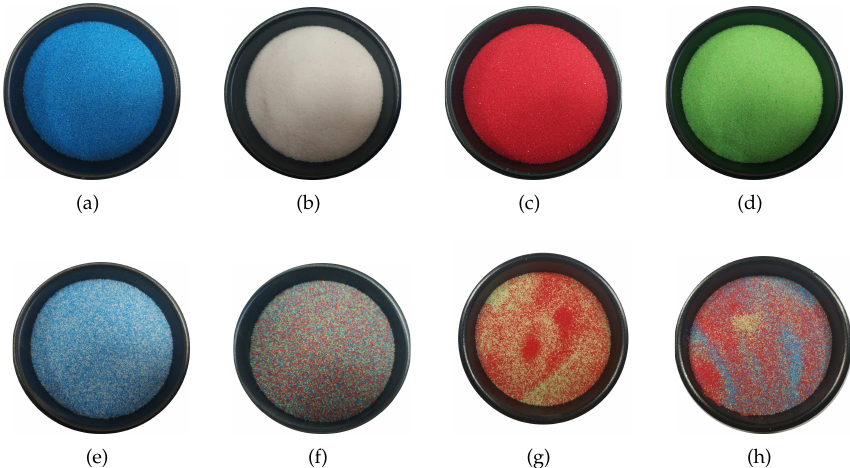
Figure 4. Laboratory created data for unmixing performance evaluation (RGB images). Subfigures ( a – d ): pure quartz sand of 0.03 mm of four colors, and they serve as pure materials for providing endmembers. Subfigures ( e , f ): uniform mixtures of sand of two ( e ) and three colors ( f ). Subfigures ( g , h ): mixtures with spatial patterns of sand of two ( g ) and three colors ( h ). Square regions of 60-by-60 pixels in the center of each subfigures are clipped out and used in experiments.